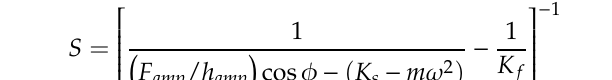
Figure 2. Optical microscopic images of the rolled AZ31 samples in the 0°, 45°, 90°, and vertical (ND) directions.